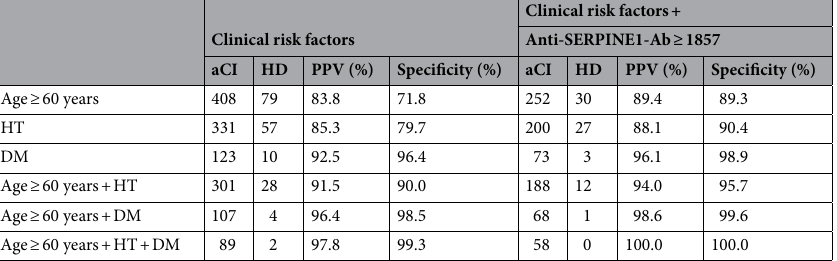
Table 6. Positive predictive value including the factors associated with the prediction of acute cerebral infarction. Results of the multivariate analysis were used to determine the positive predictive value based on the clinical factors that were particularly relevant. The numbers under aCI and HD indicate the number of participants. The left side of the table shows the number of people with only clinical risk factors, whereas the right side shows the number of people with clinical risk factors and anti-SERPINE1 antibody levels above the cutoff value. The total number of aCI and HD were 459 and 281, respectively. HT hypertension, DM diabetes mellitus, disease, aCI acute cerebral infarction, HD healthy donor, PPV positive predictive value, Ab antibody.